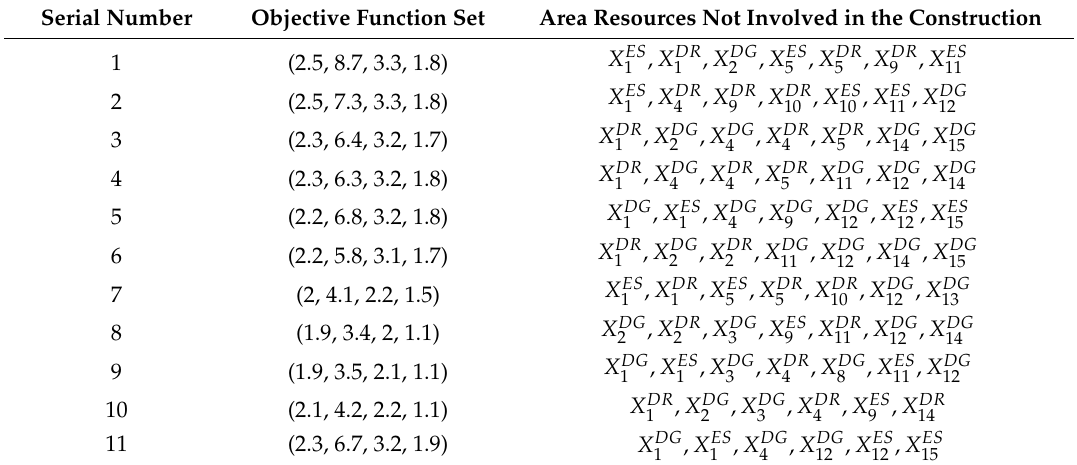
Table 2. Optimal solution set of